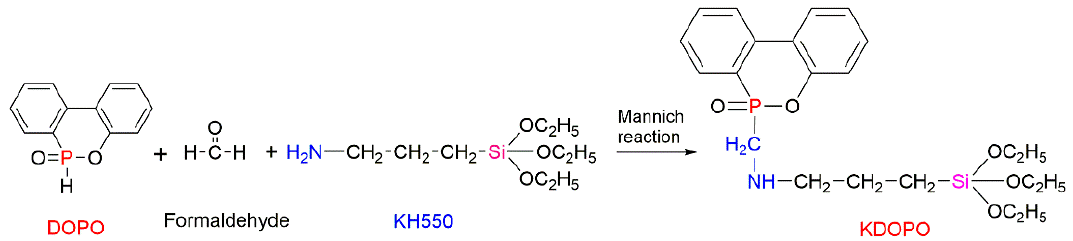
Figure 13. A synthetic route for the preparation of the KDOPO FR formulation [86]. KDOPO: Mannich reaction between the 9,10-dihydro-9-oxa-10-phosphaphenanthrene-10-oxide (DOPO) derivative and γ -aminopropyltriethoxysilane (KH550).